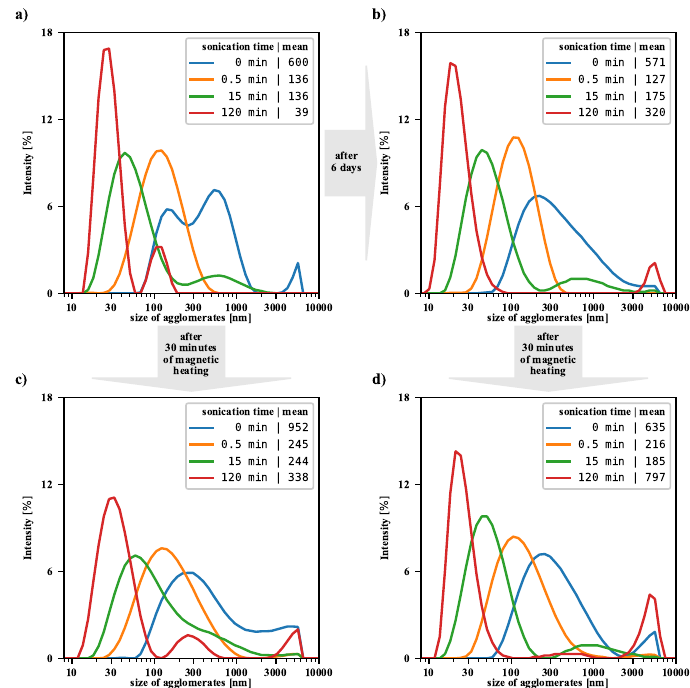
Figure 5. The graph shows the intensity-based size distributions for a suspension initially subjected to different durations of ultrasonic treatment. ( a , b ): without the additional RFMH; ( c , d ): additionally subjected to the 30’ RFMH (performed the day before DLS measurements); ( a , c ): measurements were taken 1 day after nanoparticle synthesis; ( b , d ): measurements were taken 7 days after the synthesis of nanoparticles. For each panel in the last column of the legend, the value of the mean size distribution for each case is included. The graph shows the intensity-based size distributions for suspension pre-treated with ultrasound. The top left panel shows DLS results for the colloidal suspension of nanoparticles made the previous day (without using RFMH). For each drawing, the last column of the legend contains the mean size distribution for each